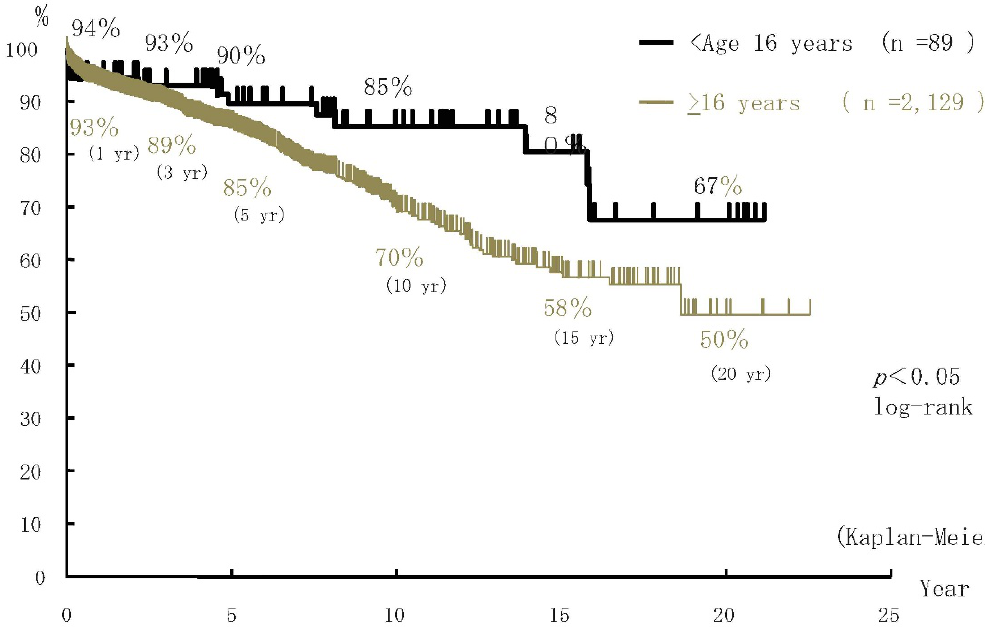
Figure 3 - Graft Survival of ABOi Compared between Pediatric and Adult Recipients.